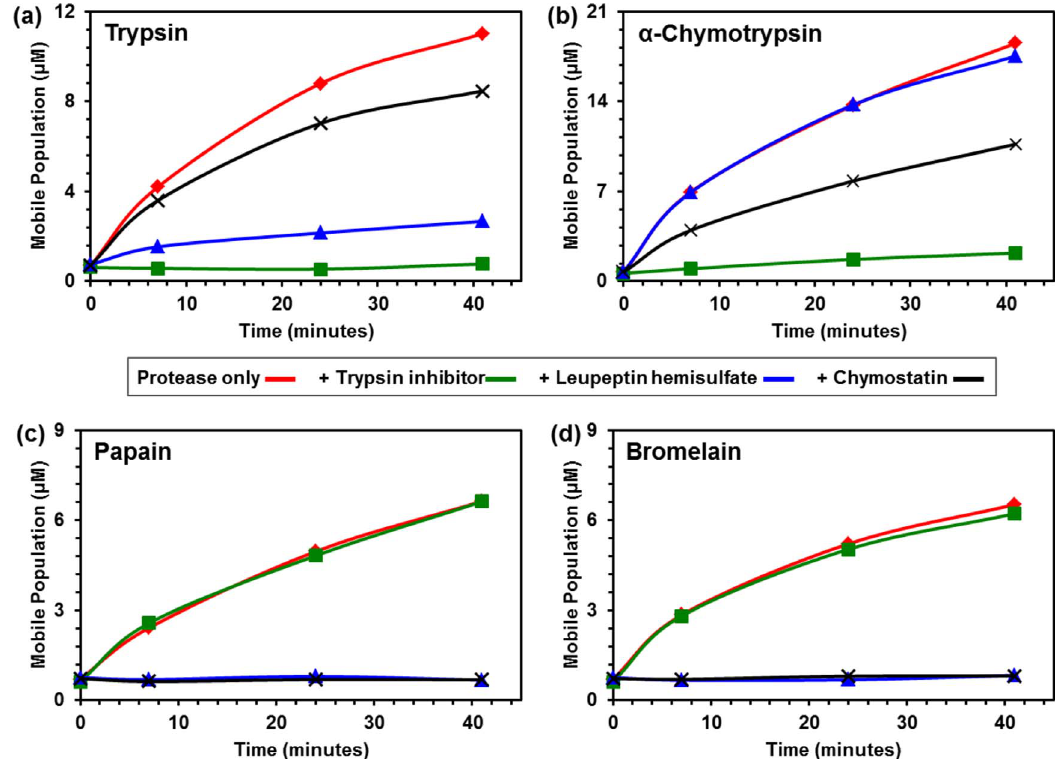
Figure 5. Increase in mobile population over a 41-minute time course for digestion of HgA by four proteases: Trypsin, a - chymotrypsin, papain, and bromelain. Each protease acted alone or in the presence of three protease inhibitors. Error bars are too small to be seen at this